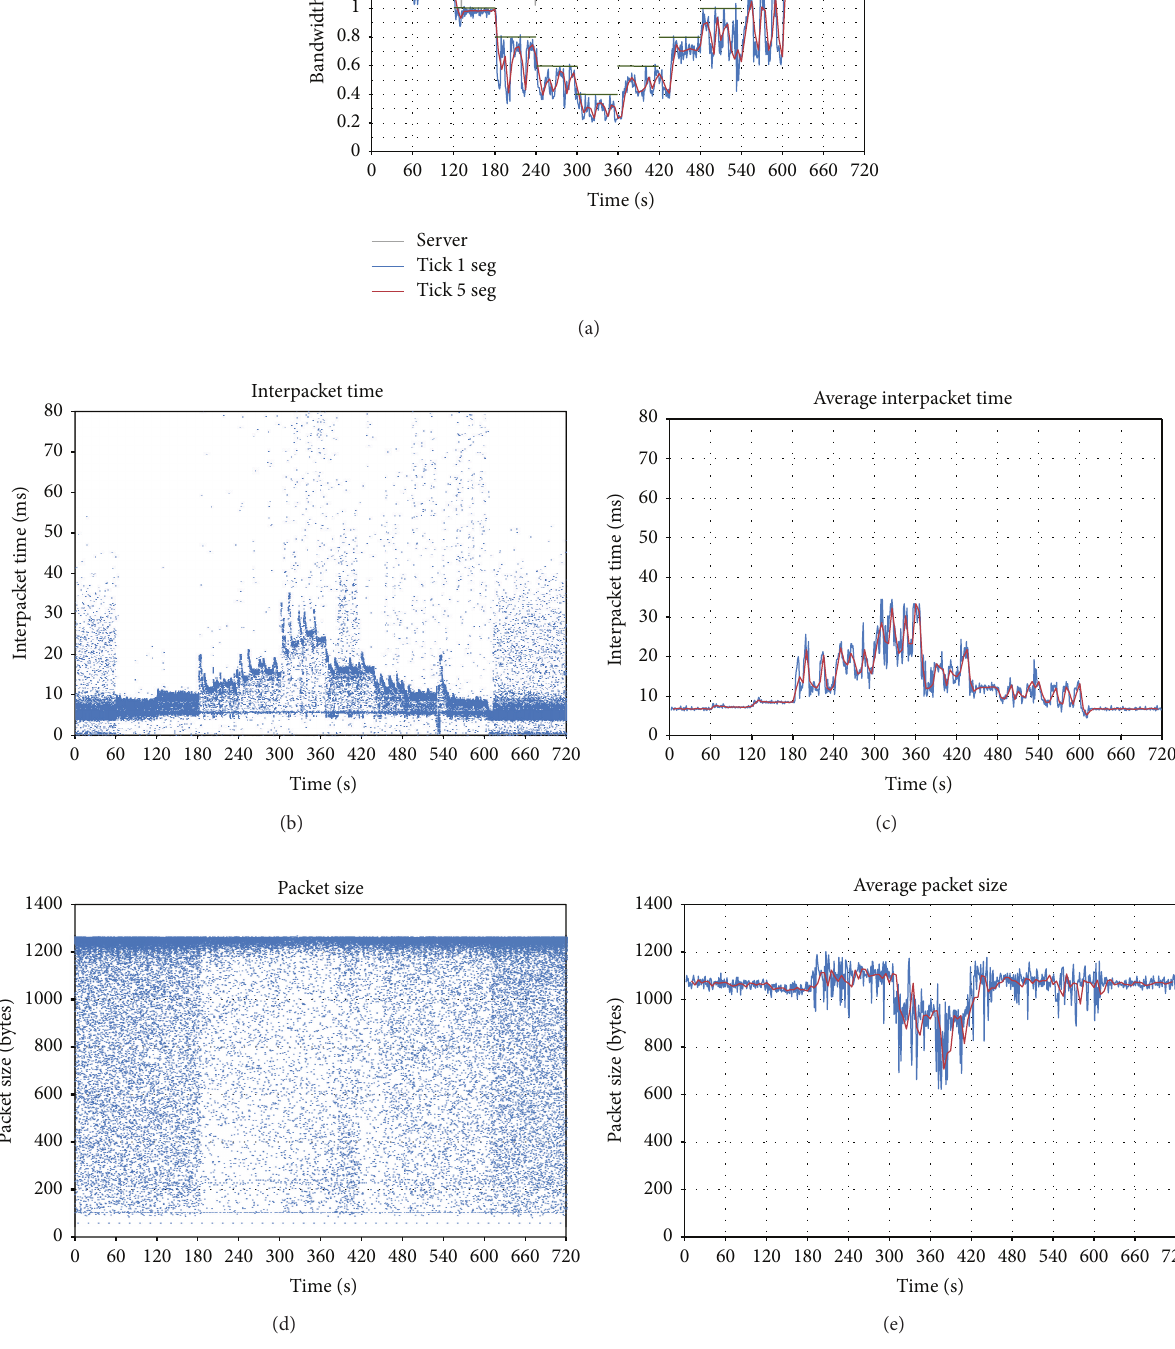
Figure 2: Effect of downlink bandwidth limitations on Vidyo : (a) evolution of sent throughput; (b) interpacket time; (c) average interpacket time; (d) packet size; (e) average packet